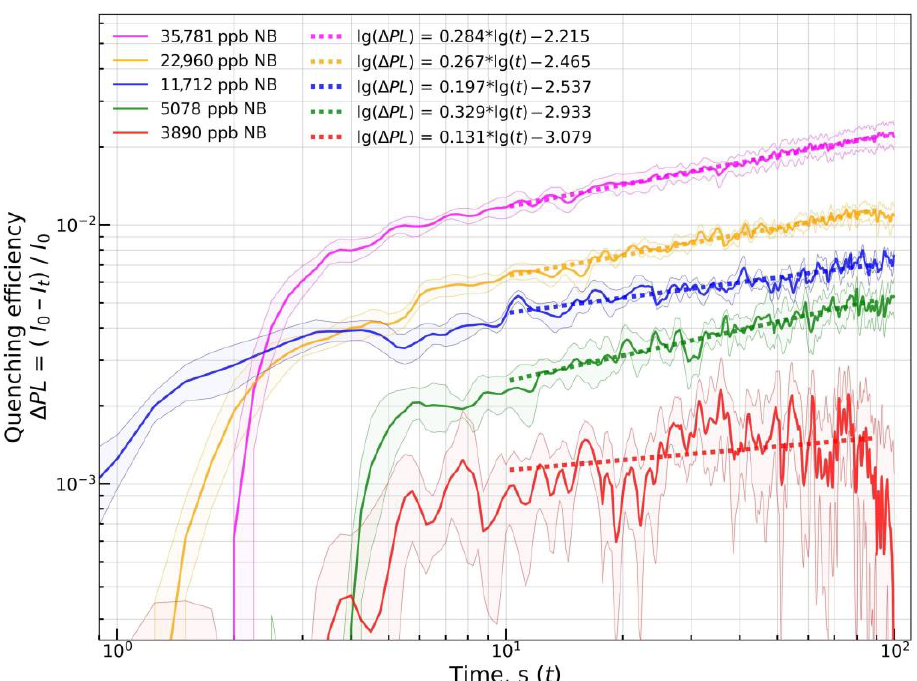
Figure 13. lg( ∆ PL ) vs. lg( t ) plot for material mF/Elsp at various NB vapor concentrations. A set of at least four sensor materials on the sensor element was used to record each quenching response. Each solid lines and shaded area around it represent the mean and the std.dev. of the quenching response at selected time point. Dashed lines are linear approximations of lg( ∆ PL ) vs. lg( t ).